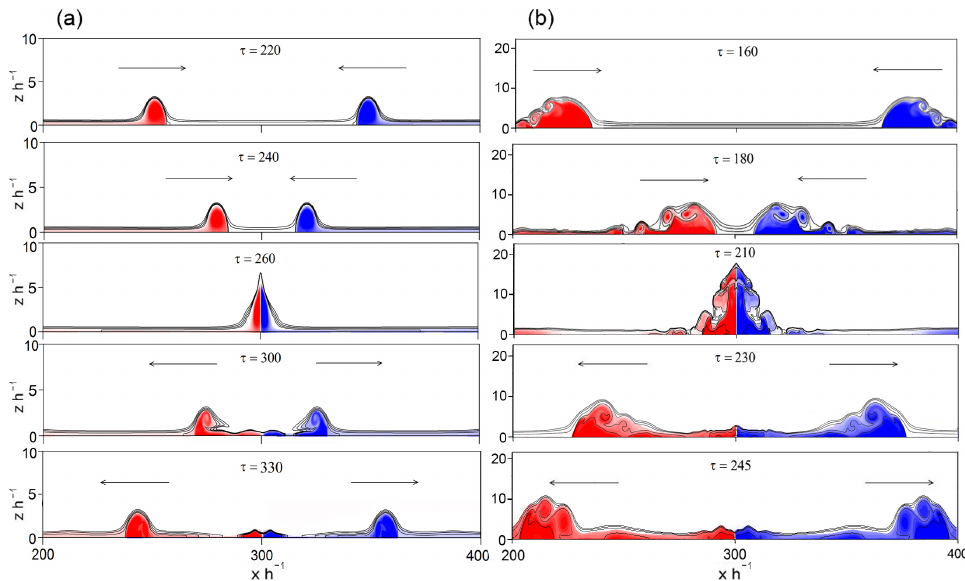
Figure 6. Snapshots of the density isopycnals during the collision of ISWs. (a) Case (A9; A9). (b) Case (A13; A13). The trapped cores are visualized by dyed fluid.